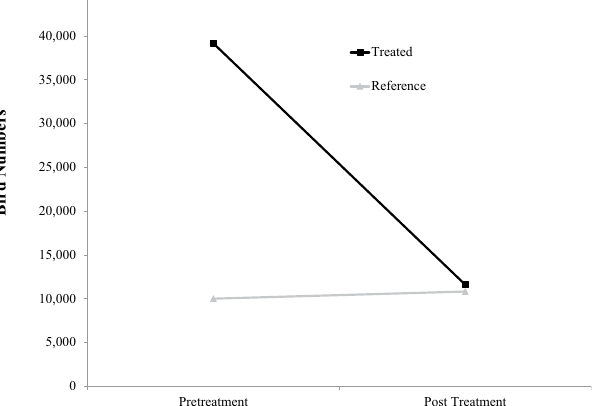
Figure 1. Mean number of European starlings ( Sturnus vulgaris ) observed on starling controlled (treated) and non-starling controlled (reference) feedlots before and after DRC-1339 applications within Kansas, Texas, Colorado, Missouri and Iowa, USA in 2013.